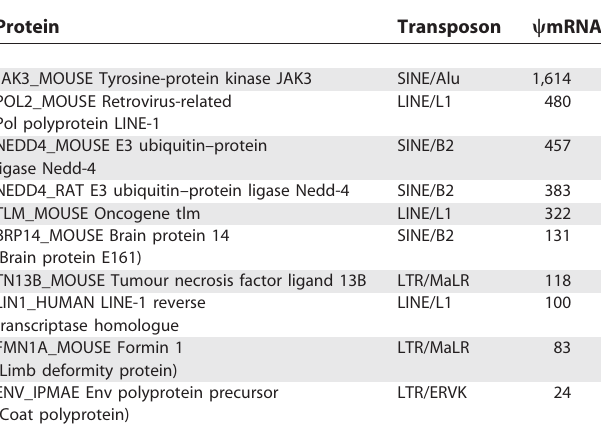
Table 2. Top Ten Proteins with Most w mRNA Homologues